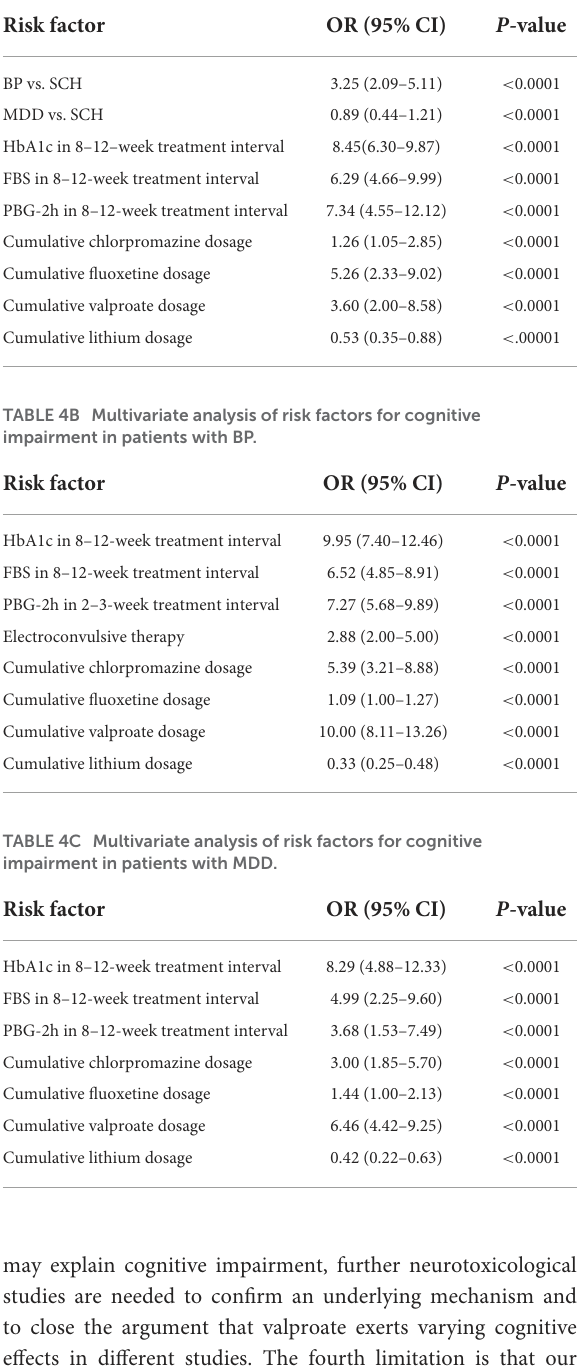
TABLE 4D Multivariate analysis of risk factors for cognitive impairment in patients with